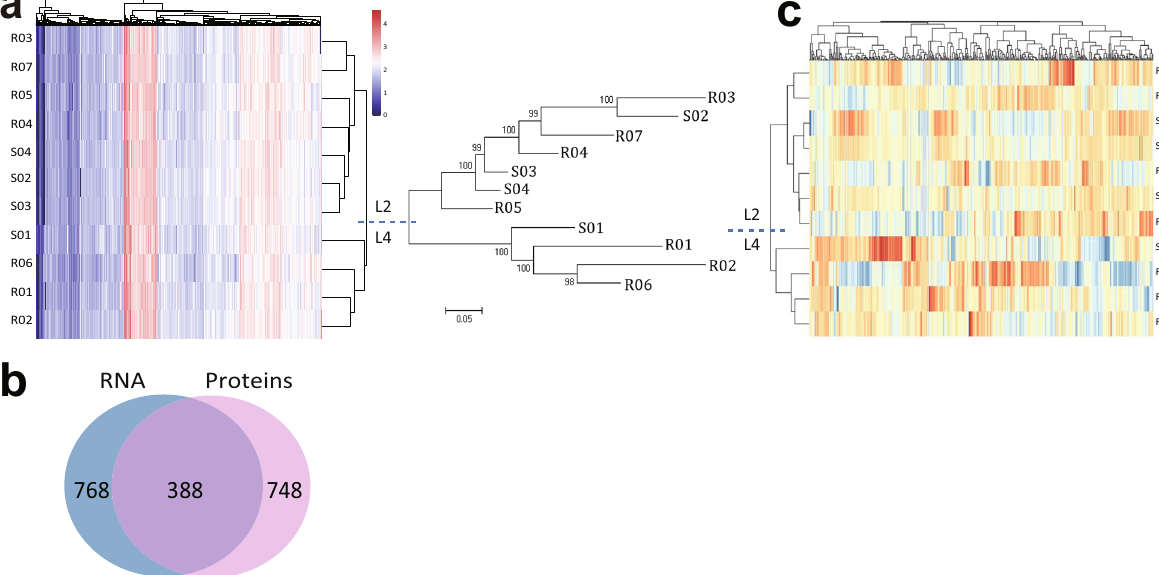
Fig. 2 Phylogenetic relationships are re fl ected in the transcriptome and proteome. a Hierarchical clustering of transcriptome data from 11 M. tuberculosis isolates and phylogenetic analysis of the same isolates based on SNP variation. The scale bar represents the number of SNP substitutions per SNP site. b Venn diagram showing the number of genes that are differentially expressed at both the RNA (Log 2 (fold change) >1 or − 1, p < 0.05) and protein (Log 2 (fold change) >1 or < − 1, p < 0.05) levels in L2:L4 strain comparisons. c Hierarchical clustering of the 11 isolates using transcriptomic data from the 388 overlapping genes differentially-expressed at the transcriptome and proteome